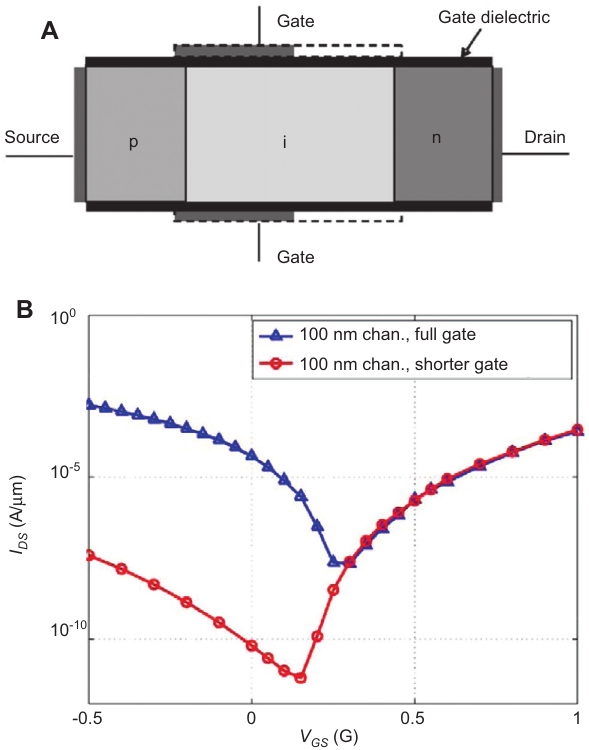
Figure 8 (A) N-type TFET (p + source, intrinsic channel, and n + drain) with different gate alignment: the dashed line shows the conven- tional gate structure with a full gate, the filled box represents a shortened gate. (B) Simulated transfer characteristics of TFETs with different gate alignment. Source and drain have the same doping concentration: 10 20 /cm 3 ; channel doping: p-type, 10 15 /cm 3 . For the full gate (blue) device: source-drain overlap is 5 nm. For the short- ened gate (red) device: source-drain separation is 15 nm. Reduc- tion of the source-drain overlap with 20 nm reduces the ambipolar current with three to five orders of magnitude. Reprinted from